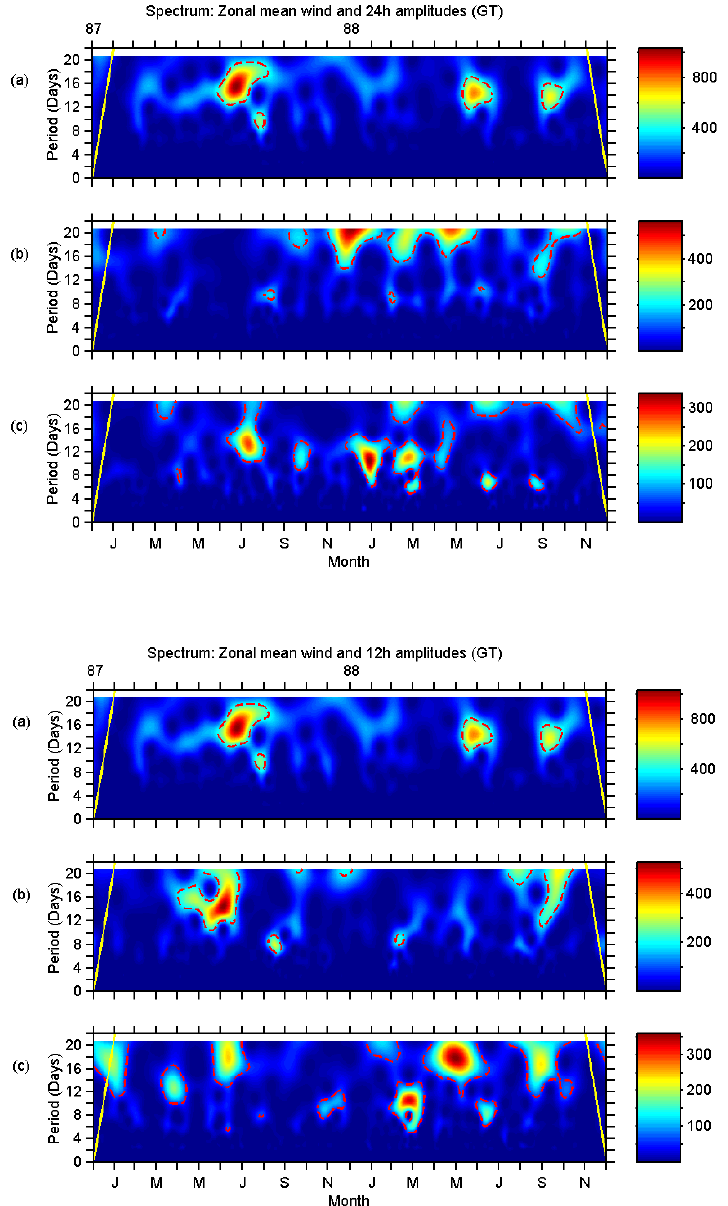
Fig. 6. The wavelet spectrum of (a) the zonal mean wind, (b) the zonal ampli- tudes of the semidiurnal tide and (c) the meridional amplitudes of the semidiur- nal tide at